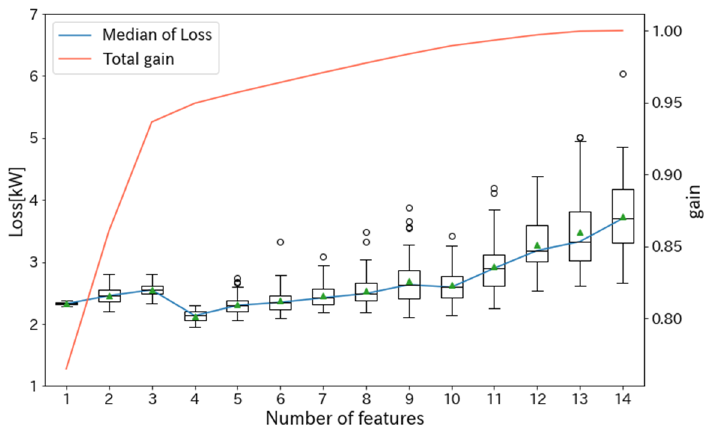
Figure 5. Number of features, 2-week average Loss in LUBE, and total gain. Table 3. Statistics of 2-week average